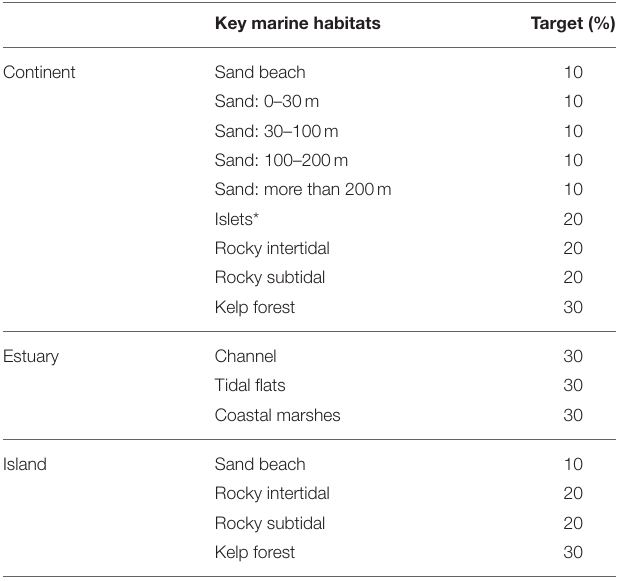
TABLE 2 | Biophysical conservation objectives and targets based on the Marine Life Protection Act Initiative. Key marine habitats